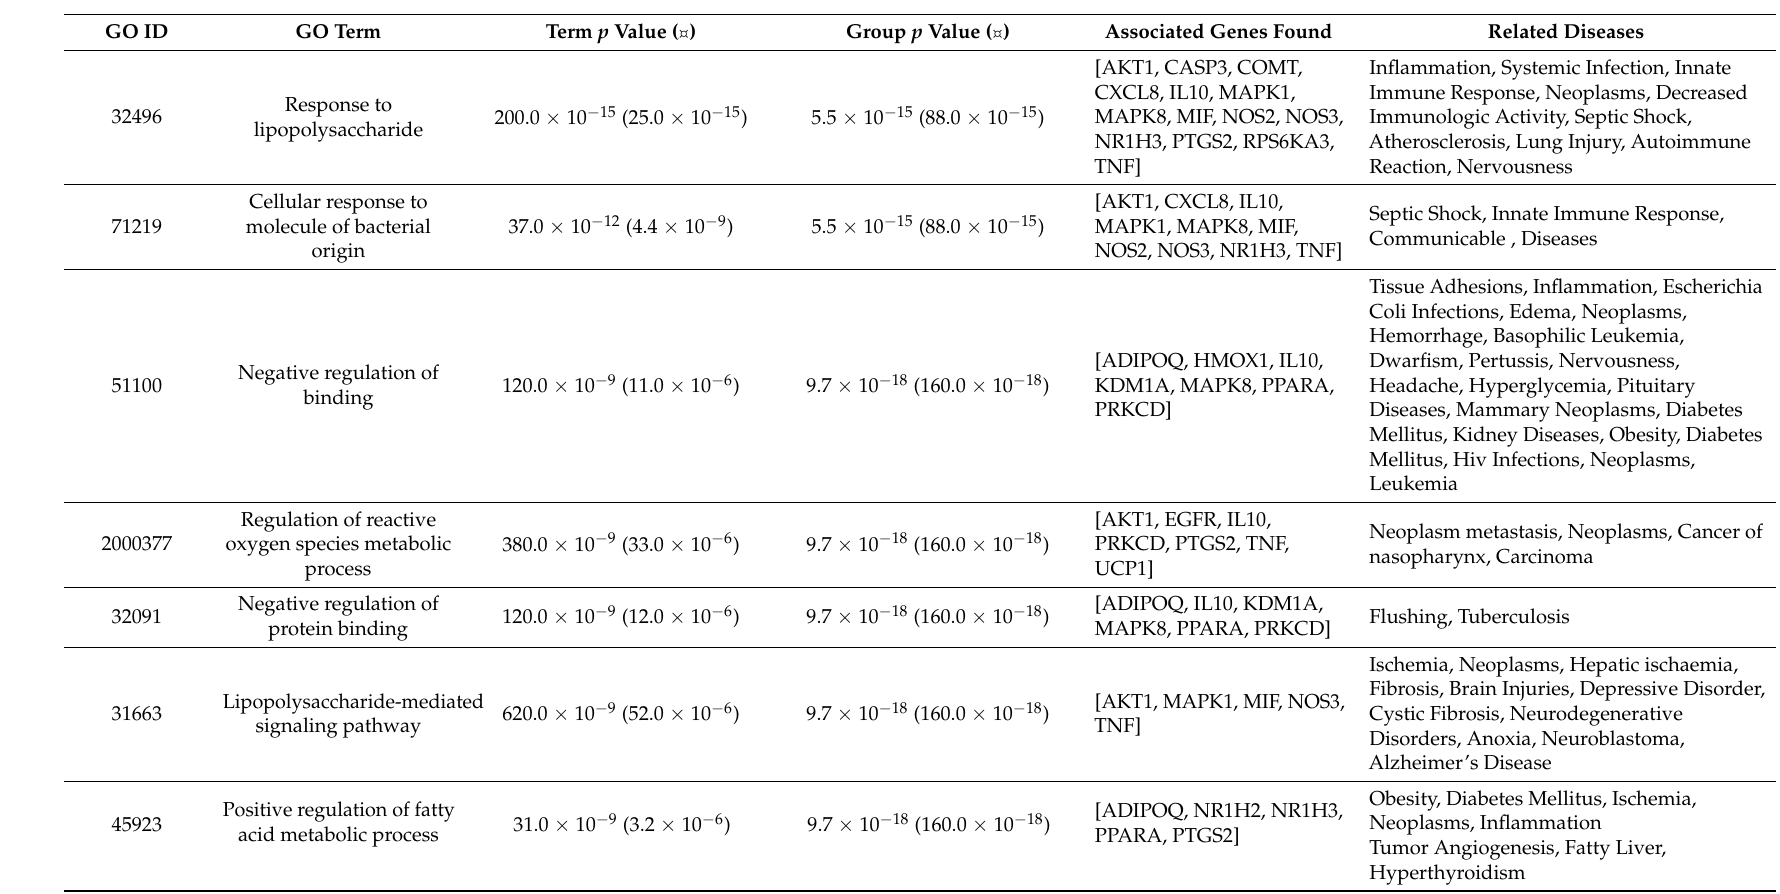
Table 3. Cont. Table 3. Retrieval of GO terms and their related genes via ClueGO. Table 3. Retrieval of GO terms and their related genes via ClueGO.